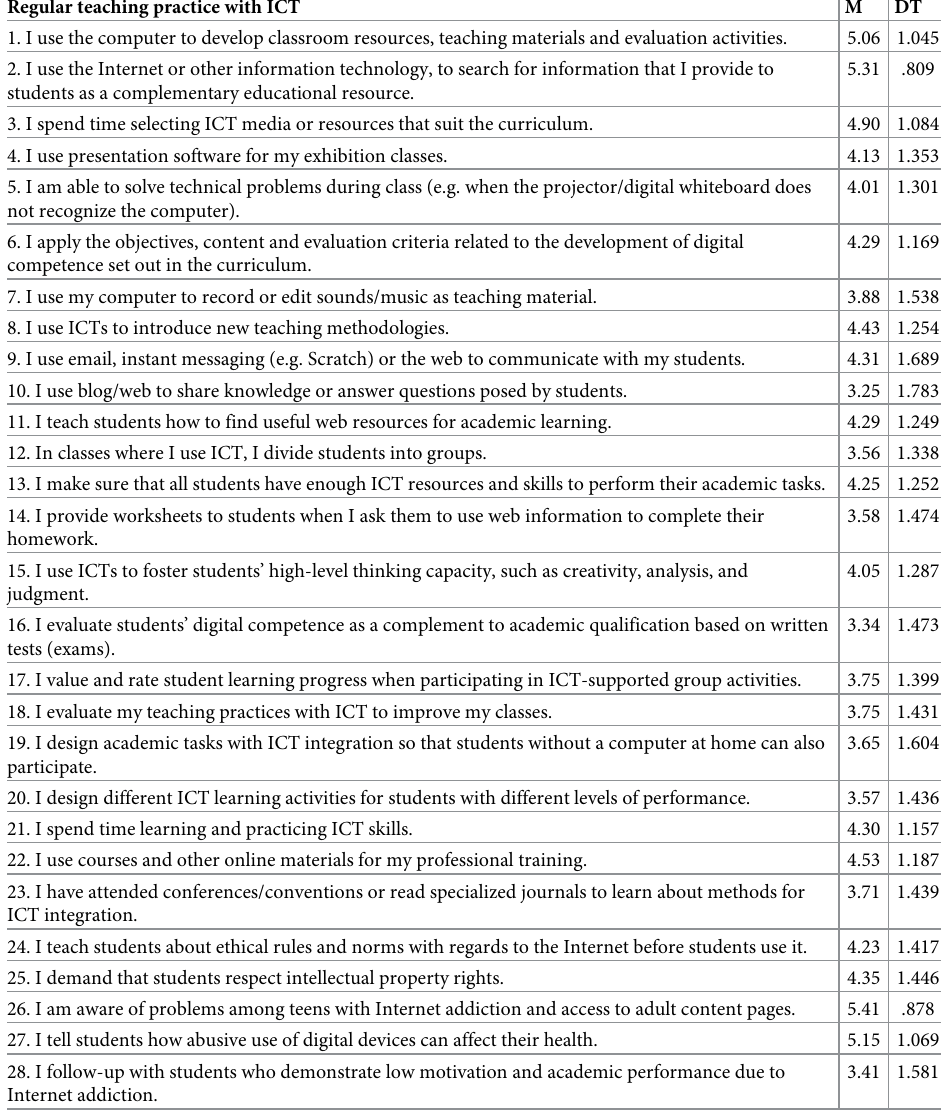
Table 2. Description of the usual teaching practice with ICT: Spaces, learning results and typology (ICTTIP). Regular teaching practice with